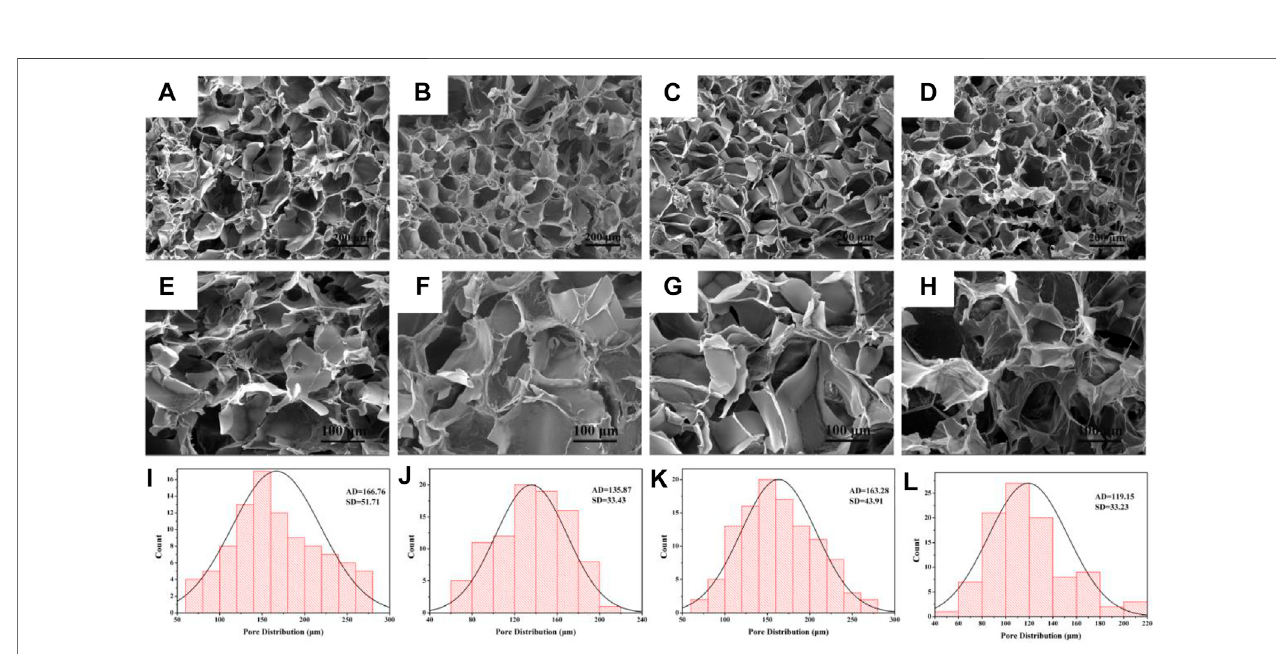
FIGURE3| Morphologyanddiameterdistributionofhydrogel. (A – D) SEMimagesofCP50,OCP50,CP100,andOCP100hydrogels(200×); (E – H) SEMimagesof CP50, OCP50, CP100, and OCP100 hydrogels (500×); (I – L) Pore statistics of cross-section of CP50, OCP50, CP100, and OCP100 hydrogels.